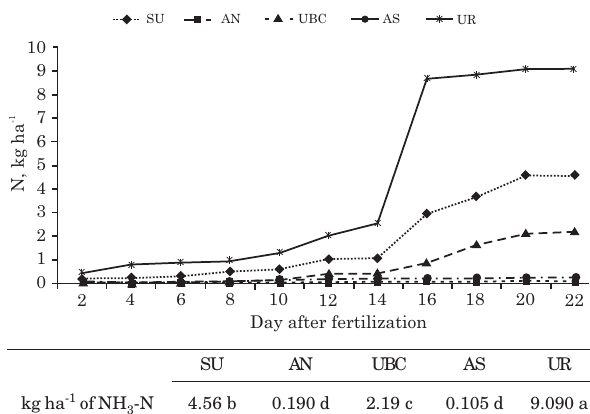
Figure 1. Concentration of accumulated NH 3 -N at each sampling after fertilization. UR: conventional urea, AS: ammonium sulfate, AN: